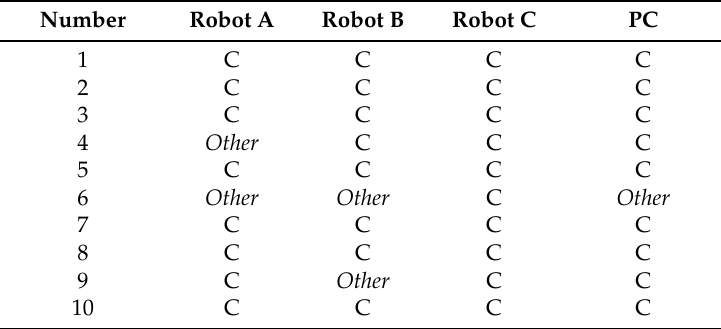
Table 1. Sound recognition results of signal type C.